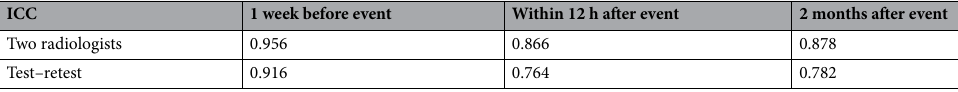
Table 1. The ICC of T2 values in bilateral menisci as independently measured by two radiologists. ICC intraclass correlation